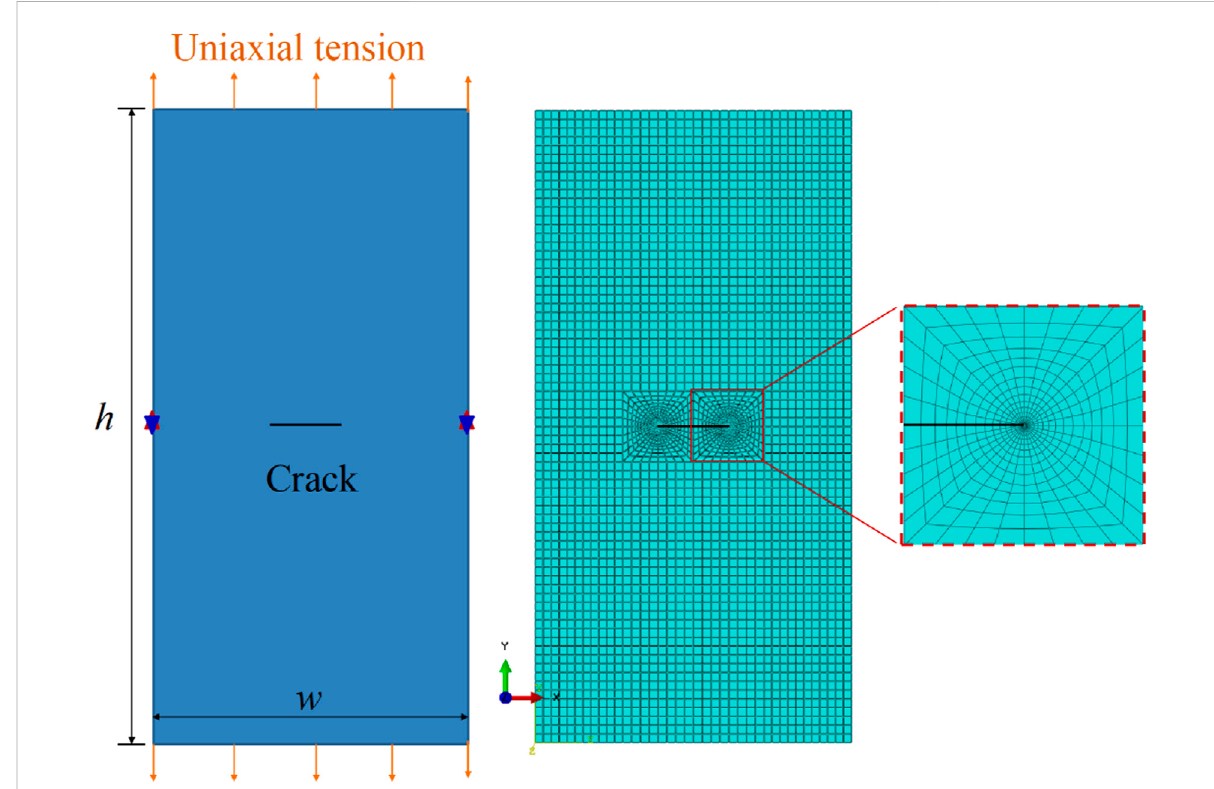
FIGURE 6 Finite element model and mesh result for the central crack sheet under uniaxial tension.